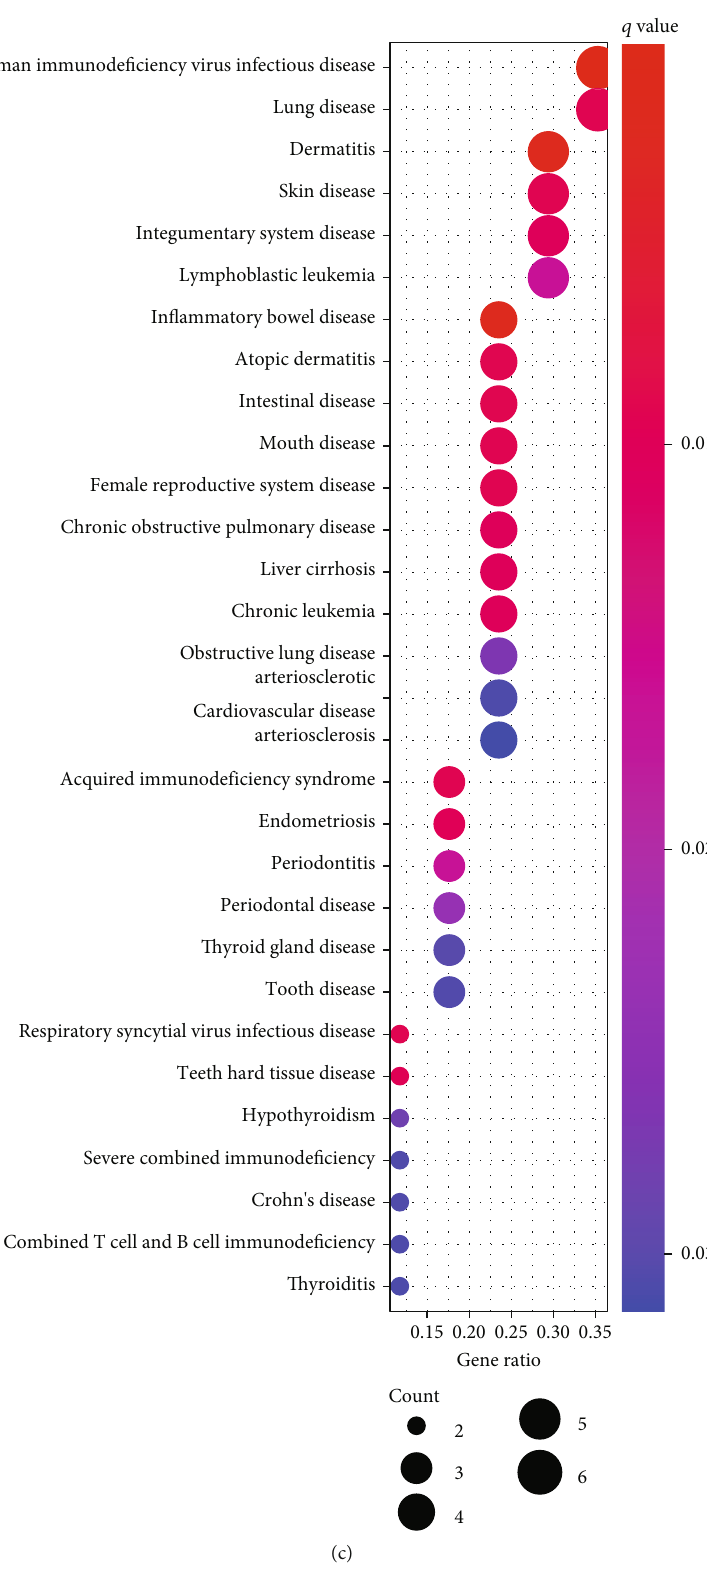
Figure 2: GO, KEGG, and DO pathway enrichments of di ff erentially expressed genes: (a) GO enrichment; (b) KEGG pathway enrichment; (c) DO enrichment